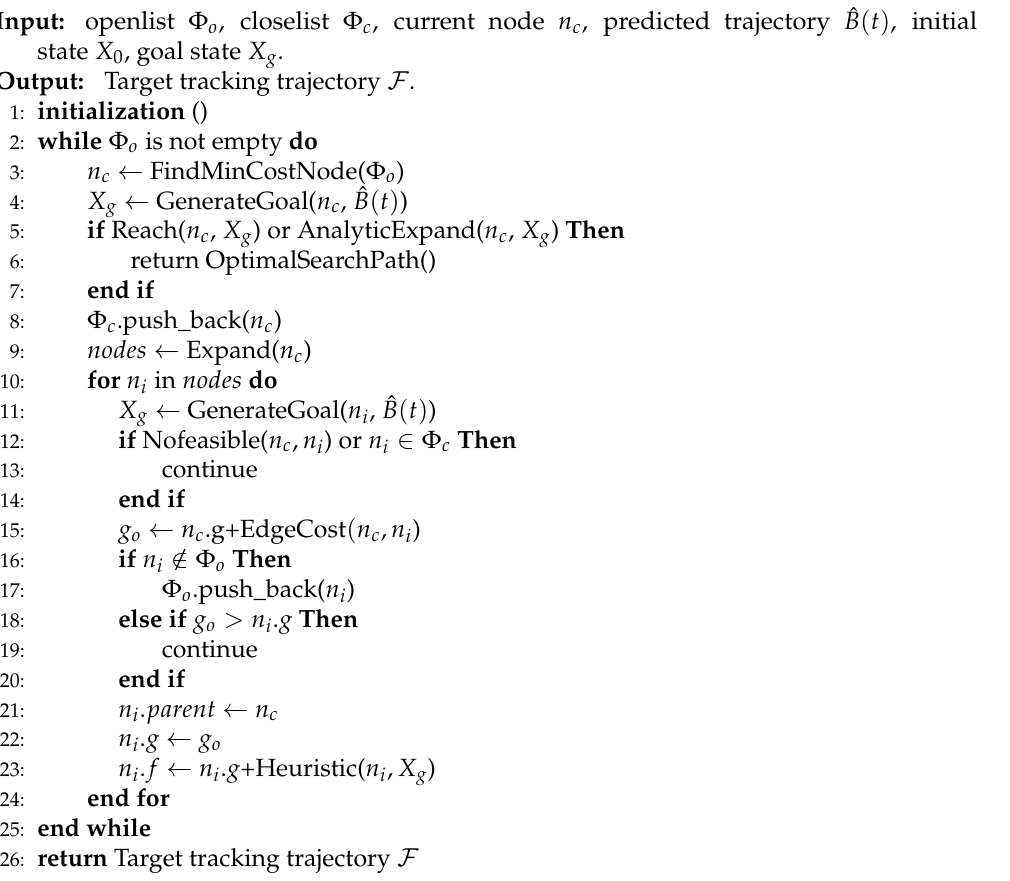
Algorithm 1 Trajectory searching for dynamic